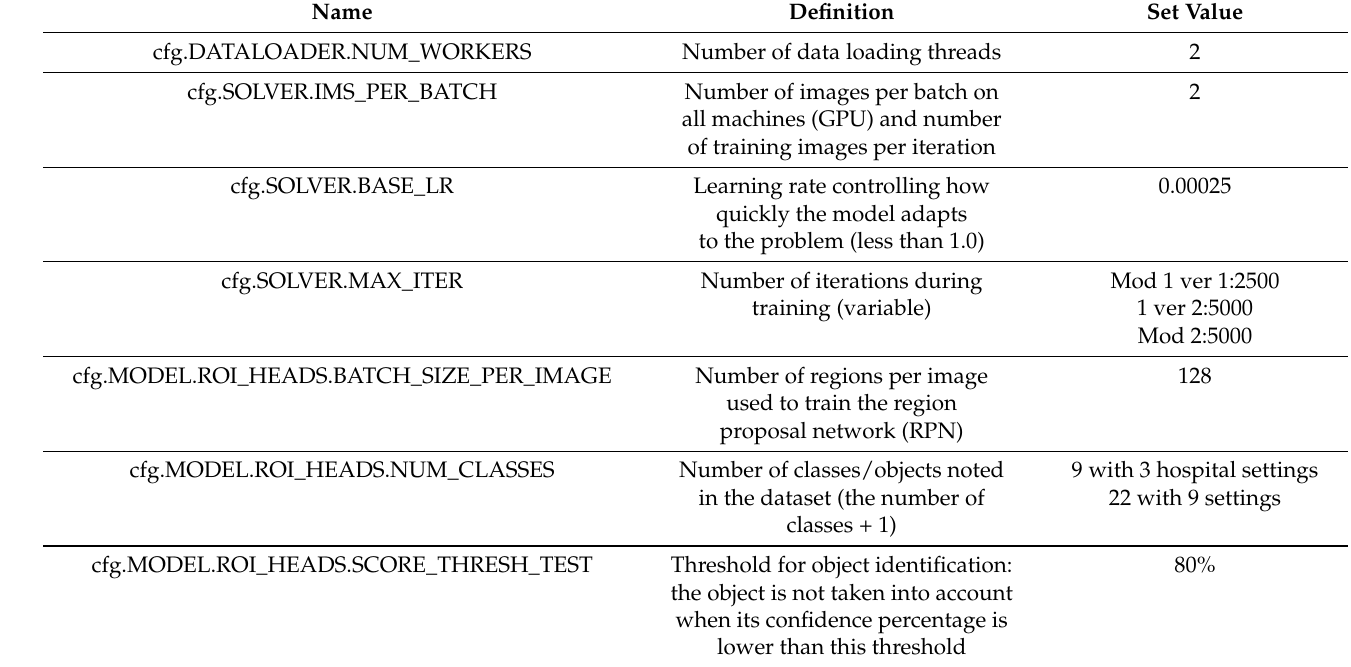
Table 5. Name, definition and set value of each hyperparameter of the Detectron2